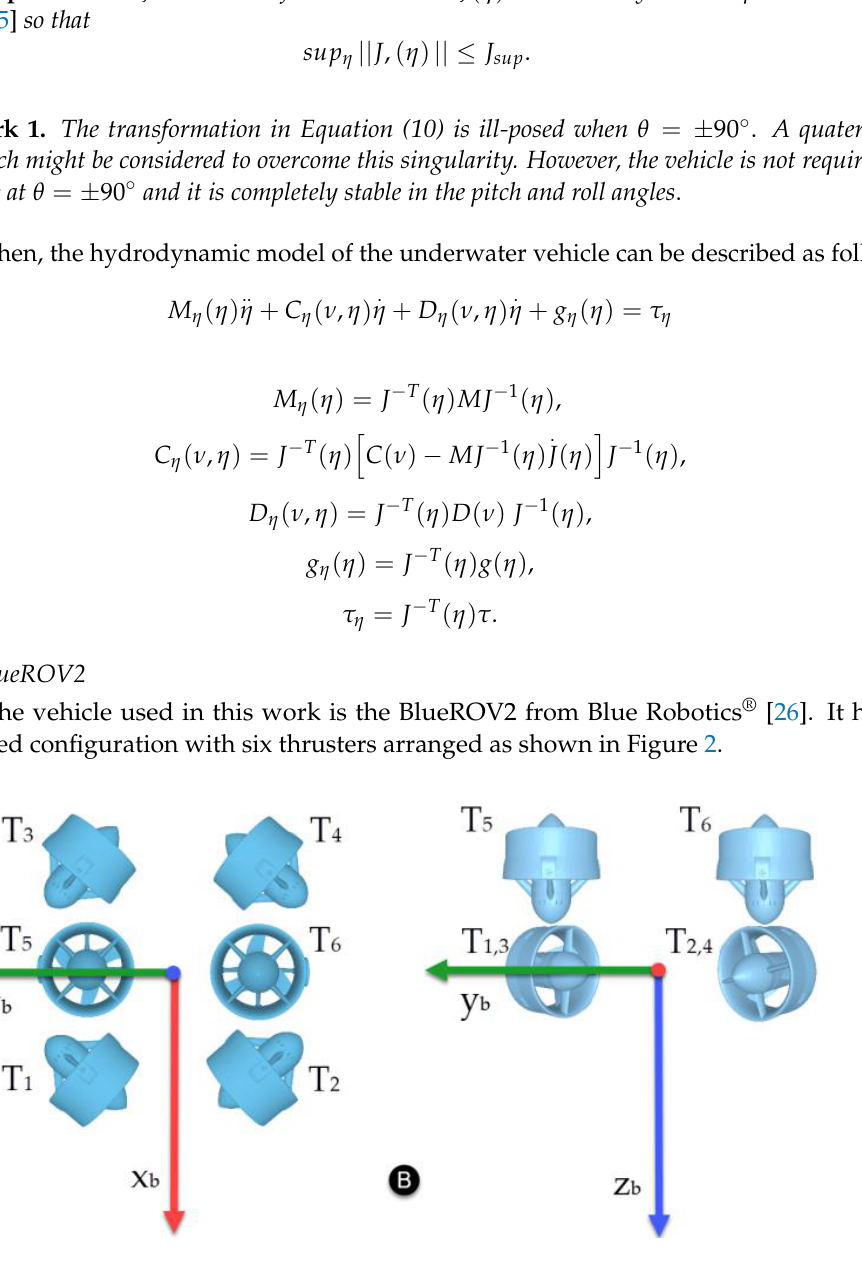
Figure 2. Thruster configuration for the BlueROV2. ( A ) Top view. ( B ) Front view.